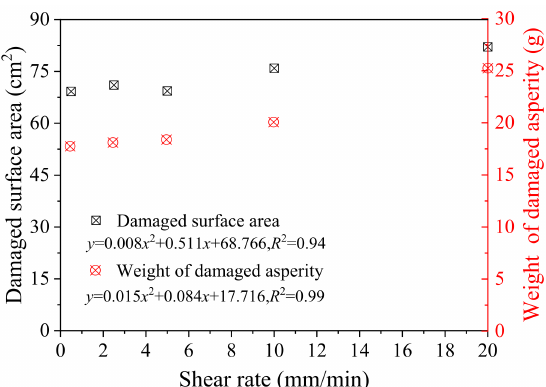
Figure 11. Damaged surface area and weight of the damaged asperity of the joint surface under diverse shear